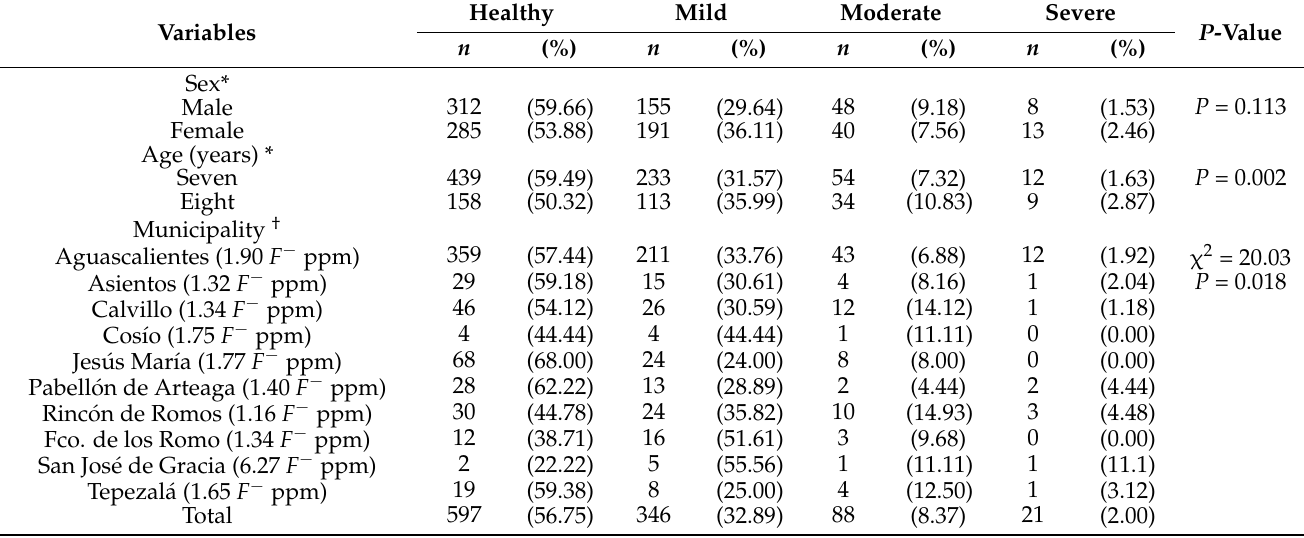
Table 2. Severity of dental fluorosis distribution according to sex, age, and the municipality of